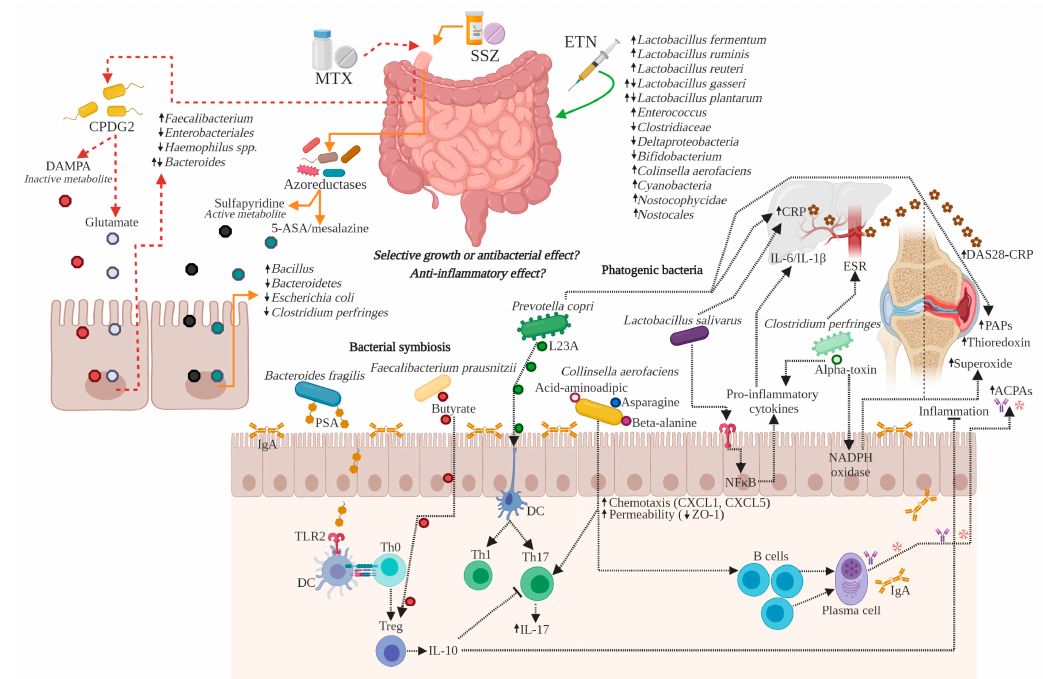
Figure 3. DMARDs-gut microbiota feedback in RA. Interactions of the MTX, SSZ, and ETN on the gut microbiota with effects direct on selective bacterial growth and antimicrobial effect. ↑ / ↓ = increased/decreased. ACPAs , anti-citrullinated peptide antibody; CXCL, chemokine ligand; CPDG2, carboxypeptidase-G2; CRP, C-reactive protein; DAMPA, 2,4-diamino-N(10)-methylpteroic acid; DC , dendritic cell; DMARDs, disease-modifying antirheumatic drugs; DAS28, disease activity score 28; ESR, erythrocyte sedimentation rate; ETN, etanercept; IgA , immunoglobulin A; IL, interleukin; L23A, ribosomal protein L23A; MTX, methotrexate ; NADPH , nicotinamide adenine dinucleotide phosphate; NF- ĸ B, nuclear factor kappa-light-chain-enhancer of activated B cells; PAPs, phosphoadenosine phosphosulfate reductase; PSA, polysaccharide A; RA, rheumatoid arthritis; SSZ, sulfasalazine; Th, T helper cell; TLR, toll-like receptor; Treg, regulatory T cell; ZO-1,